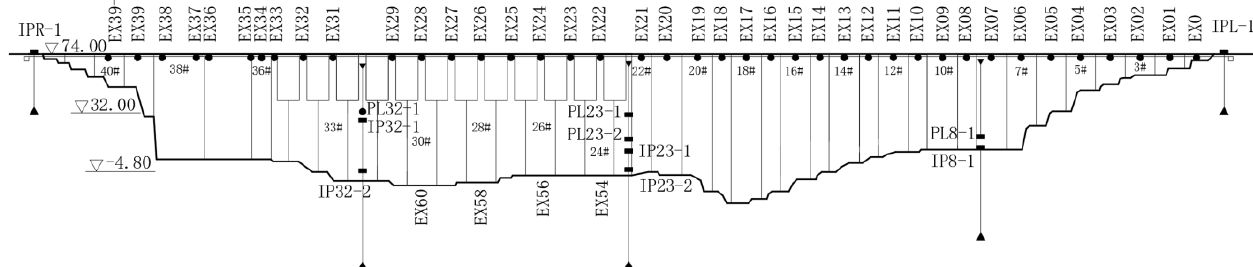
Figure 5. Layout of measuring points.